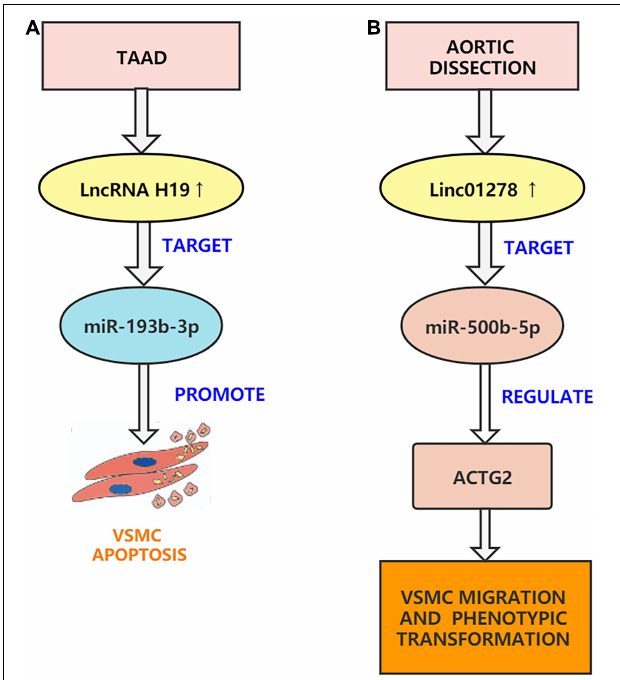
FIGURE 3 | Aortic dissection associated lncRNAs. (A) H19 can regulate the function of VSMCs through sponging miR-193b-3p and can participate in the development of AD. (B) Linc01278 sponge miR-500b-5p can regulate ACTG2 and control VSMC phenotypic transition, proliferation, and